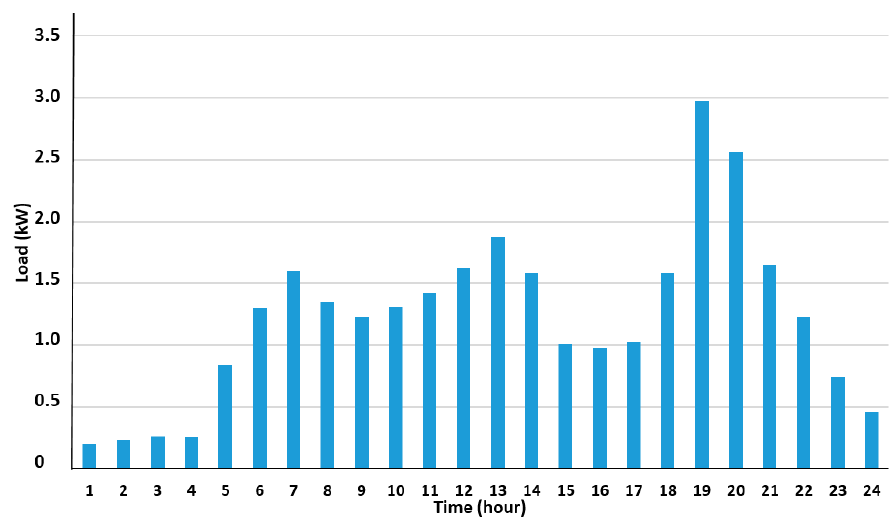
Figure 6. Daily load profile.